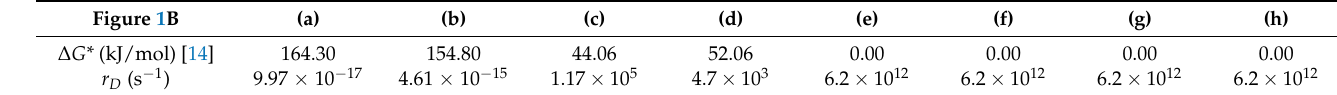
Table 2. Atomistic activation energy ( ∆ G *) [14] and the calculated atomistic forward reaction rates ( r D (Equation (1)) for the dissolution of Ca-C2 on the (100) and (100) facets for 8 different event scenarios applied in case 2. Ca-C2 dissolution (Figure 1B): (a) in the presence of Ca5, Ca6, Ca7, and Ca8; (b) in the presence of Ca5, Ca7, and Ca8; (c) in the presence of Ca5, Ca6, and Ca7; (d) in the presence of Ca7, and Ca8; (e) in the presence of Ca5 and Ca6; (f) in the presence of Ca7; (g) in the presence of Ca6; and (h) in the absence of all 4 Ca neighbors.